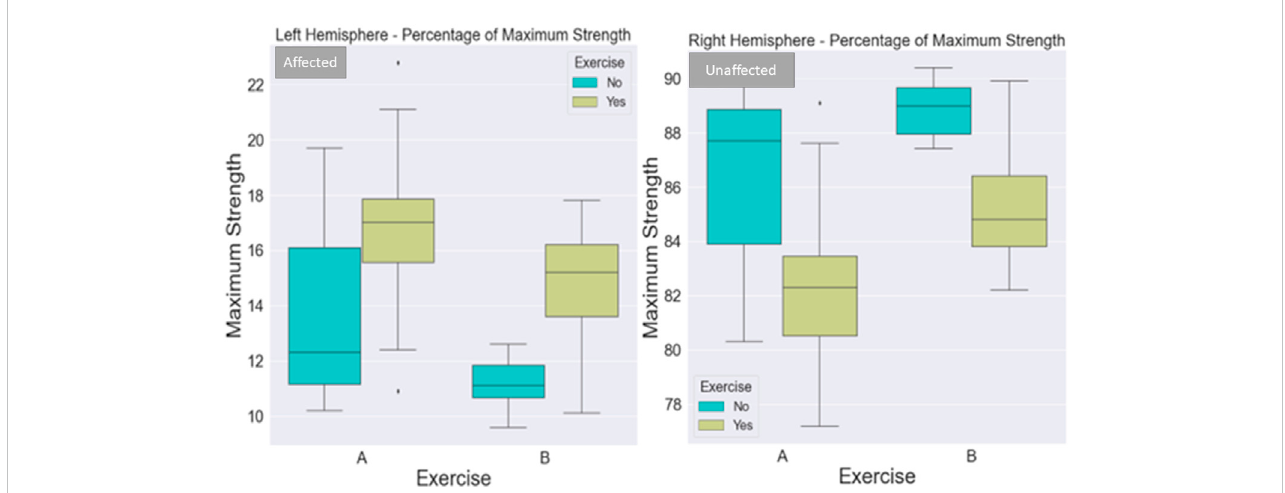
FIGURE 5 Visualization of maximum strength percentage for the left and right sides of the body. The maximum strength of the affected side (left part of the image) improved with exercise in both protocols. The maximum strength of the non-affected side (right part of the image) improved with both protocols when not combined with exercise. The exercise added to the centrifugation was very light to make a difference for the unaffected